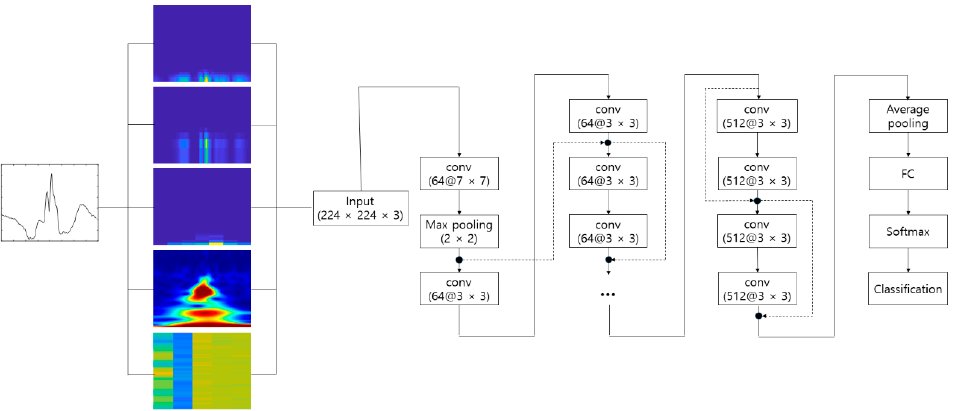
Figure 2. Structure of ResNet with the time-frequency representations as inputs.